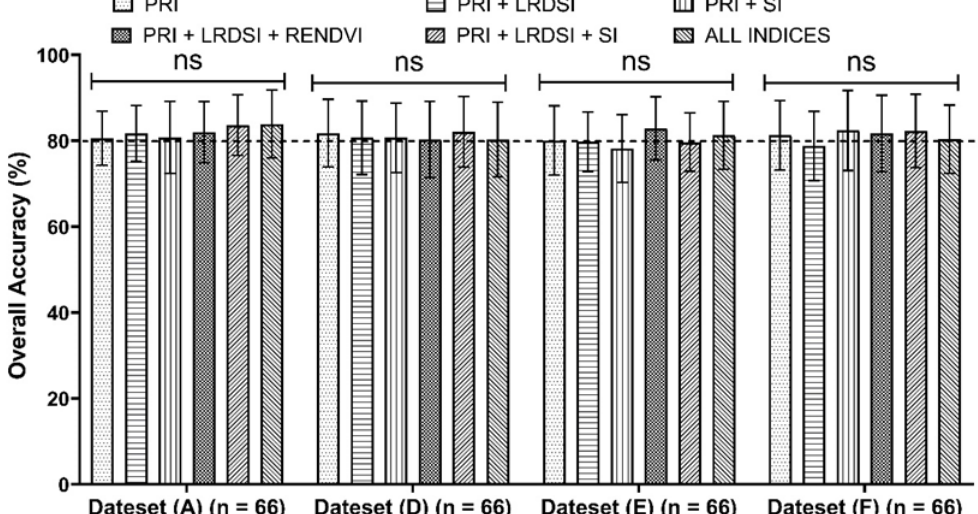
Figure 11. Overall accuracies of random forest classification based on single PRI and multi-indices. Error bar denotes standard deviation. Dotted line means overall accuracy equals 80%, and ns above histograms means not significant. n in x axis means sample numbers, and dataset details are described in Table 2.